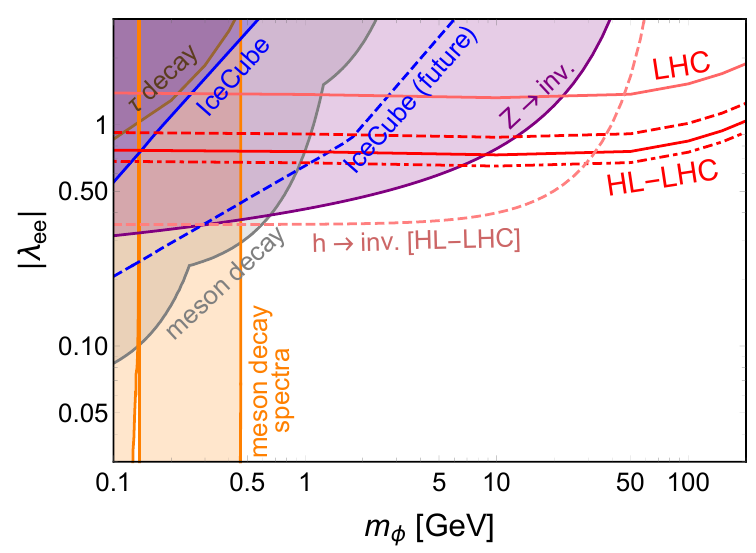
Figure 8 . Prospects of the coupling j (cid:21) ee j as a function of the scalar mass m (cid:30) at 14 TeV LHC with luminosity of 300 fb (cid:0) 1 (solid thin red line) and HL-LHC with 3 ab (cid:0) 1 and with systematic errors of 0% (dot-dashed thick red line), 10% (solid thick red line) and 20% (dashed thick red line). Also shown are the low-energy limits (cf. table 1) from meson decay (gray), (cid:28) decay (brown), heavy neutrino searches in meson decay spectra (orange), invisible Z decay (purple) and the prospect of invisible SM Higgs decay at HL-LHC (dashed pink), the current IceCube limits on neutrino-neutrino interactions (blue) and prospects (dashed blue). All the shaded regions are excluded.